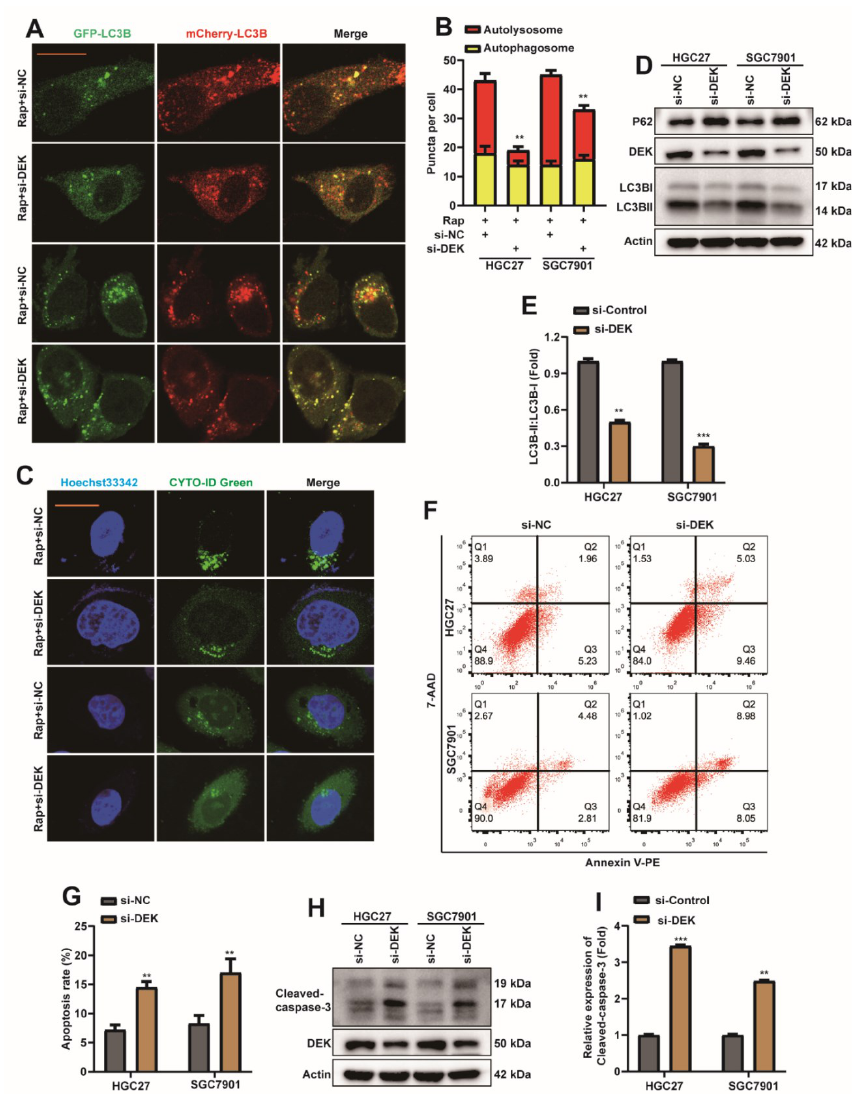
Figure 3. DEK promotes autophagy and inhibits apoptosis in GC cells. ( A ) si-DEK or si-NC were transfected into HGC27 or SGC7901 cell lines stably expressing mCherry-EGFP-LC3B. Cells were treated with 5 nM rapamycin (Rap) 24 h after transfection, and autophagic flux was observed 8 h later (scar bar = 40 µ m) (**: p < 0.01). ( B ) Autophagosome (red dots) and Autolysosome (yellow dots) were counted and analyzed. ( C ) si-DEK or si-NC were transfected into HGC27 or SGC7901 cell lines. Cells were treated with 5 nM rapamycin (Rap) 24 h after transfection, and the level of autophagy was observed 8 h later. ( D , E ) si-DEK or si-NC were transfected into HGC27 or SGC7901 cell lines, and cells were harvested 36 h later. Western Blot detection of DEK, p62, LC3B proteins. The ratio of LC3BII/I was analyzed by normalization with Actin ( n = 3, **: p < 0.01, ***: p < 0.001). ( F , G ) si-DEK or si-NC were transfected into HGC27 or SGC7901 cell lines, and the apoptosis rate was analyzed by flow cytometry after 36 h, and statistical analysis was performed. ( H , I ) si-DEK or si-NC was transfected into HGC27 or SGC7901 cell lines, and 36 h later, the expression of Cleaved-caspase-3 was detected by Western Blot, and quantitative analysis was performed ( n = 3, **: p < 0.01, ***: p <